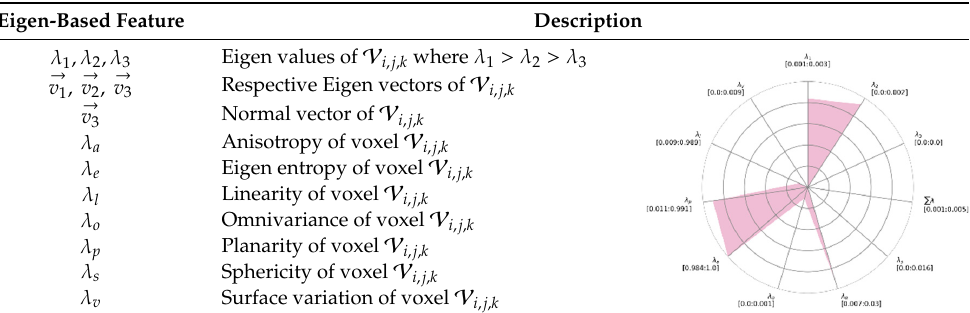
Table 1: Eigen-based features part of the SF1 feature Table 1. Eigen-based features part of the SF1 feature set.